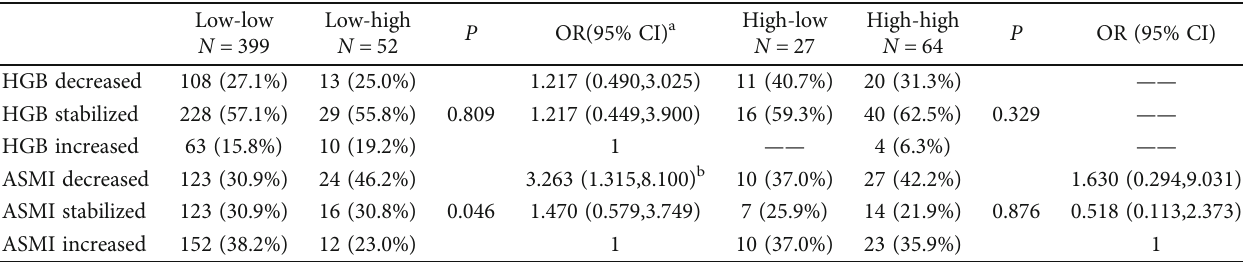
Table 2: Association between changes in the 10-year CVD risk and changes in ASMI and HGB in patients with diabetes. Low-low Low-high N = 399 N = 52